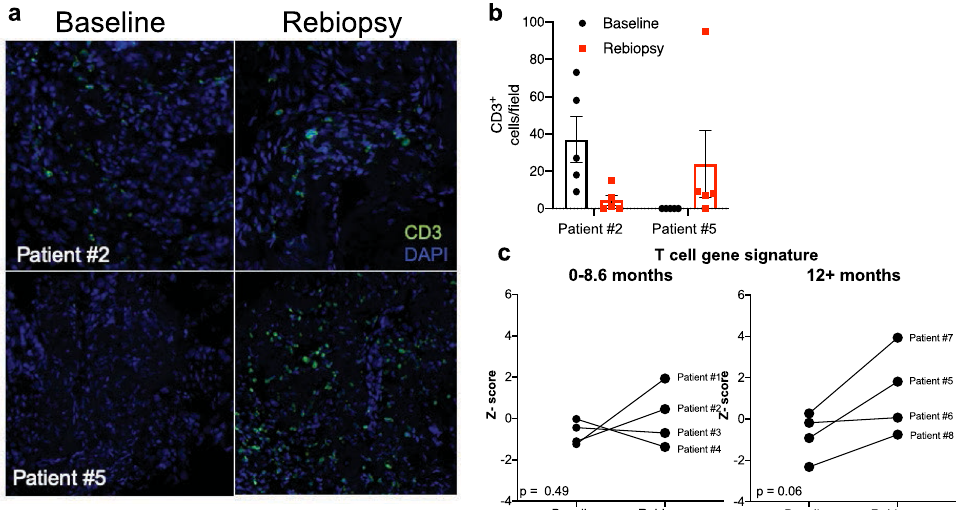
Fig. 5 T-cell content upon treatment with EGFR TKI in human lung tumor biopsies. a Single representative images of 2 matched lung tumor biopsies submitted to immuno fl uorescence staining for CD3 is shown. b Five fi elds per biopsy were counted and the individual determinations and their mean are plotted. c An immune cell signature developed by Bindea et al. 37 to deconvolute bulk gene expression data was used to infer T-cell content in the RNAseq data. Z scores for signatures predicting T cells were binned by TTP of 0 – 8.6 months or >12 months. Matched Z scores for each patient are graphed at baseline and upon re-biopsy and analyzed by paired t -test. The p values for the TTP of 0 – 8.6 months and >12 months are 0.49 and 0.06,